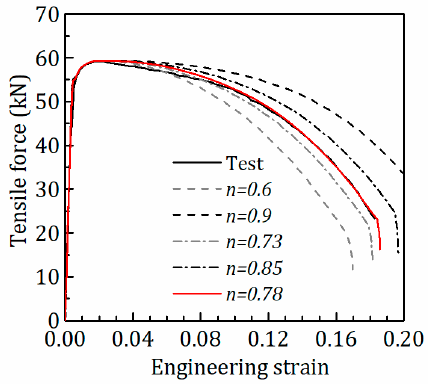
Figure 4. Comparison of FE analysis results from different Ludwik curves with test results at 500 ◦ C. Table 2. Expressions of σ eq − ε eqp curves during the post-necking phase at 20–500 ◦ C. T (°C)